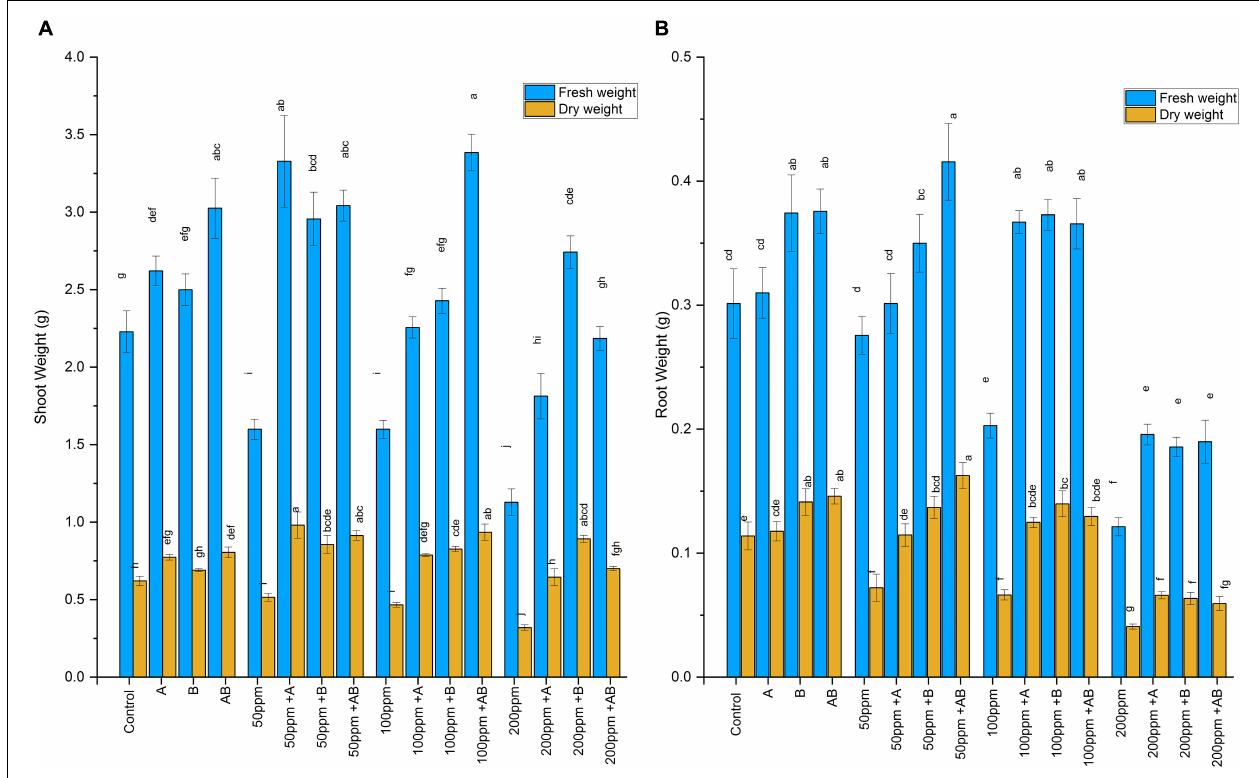
FIGURE 3 | (A) Effect of heavy metal–resistant plant growth–promoting bacteria on the fresh and dry weights of the shoots of wheat ( Triticum aestivum ) under control and heavy metal (Cd, Ni, Pb) stress conditions. Values are the mean of three replicates. Bars represent the standard error of means. Different letters above the bars indicate statistically significant difference between treatments at P ≤ 0.05. Details of treatments are the same as those in Figure 1 . (B) Effect of heavy metal–resistant plant growth–promoting bacteria on the fresh and dry weights of the roots of wheat ( Triticum aestivum ) under control and heavy metal (Cd, Ni, Pb) stress conditions. Values are the mean of three replicates. Bars represent the standard error of means. Different letters above the bars indicate statistically significant difference between treatments at P ≤ 0.05. Details of treatments are the same as those in Figure 1 .